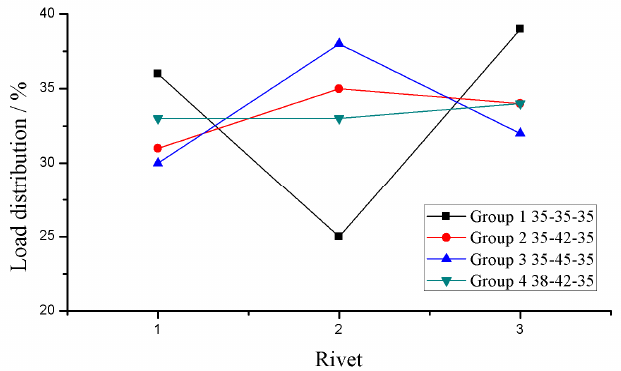
Figure 9. Tensile load transmission of a three-row riveted lap joint.